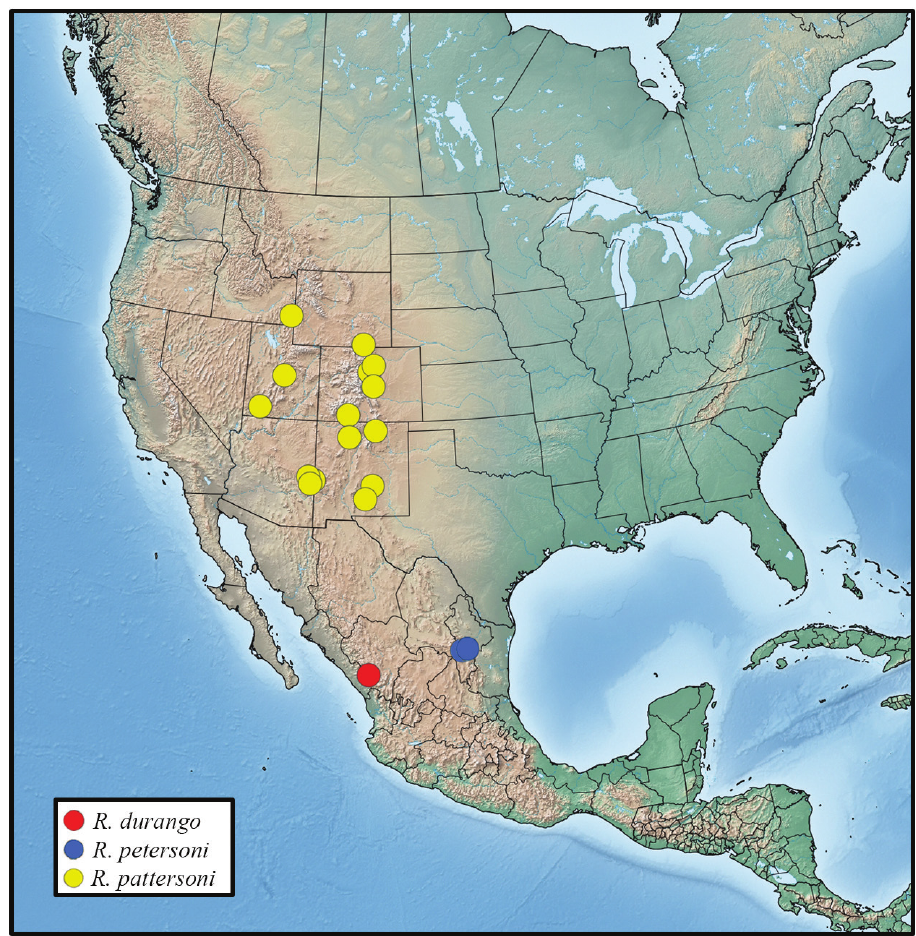
Figure 16. Distribution of examined material of Rhabdorthodes in North America. R. pattersoni (yellow), R. durango (red), R. petersoni